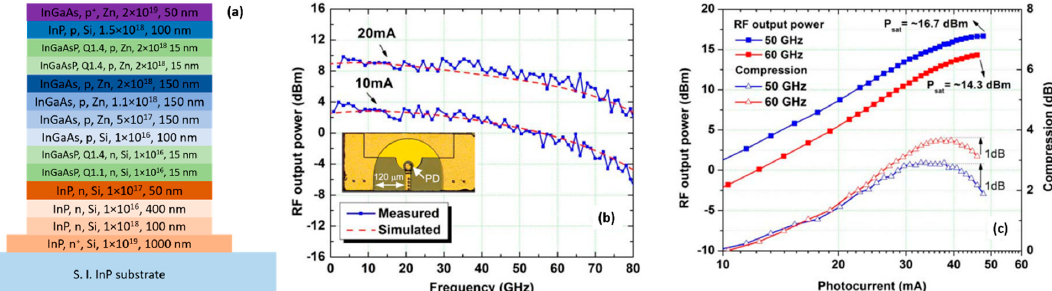
Figure 3. ( a ) Epitaxial layer design of MUTC-PD. ( b ) Measured bandwidth of 10-µm-diameter MUTC-PD. The inset shows a microscopic image of the fabricated device. ( c ) RF output power measurement of the MUTC-PD.